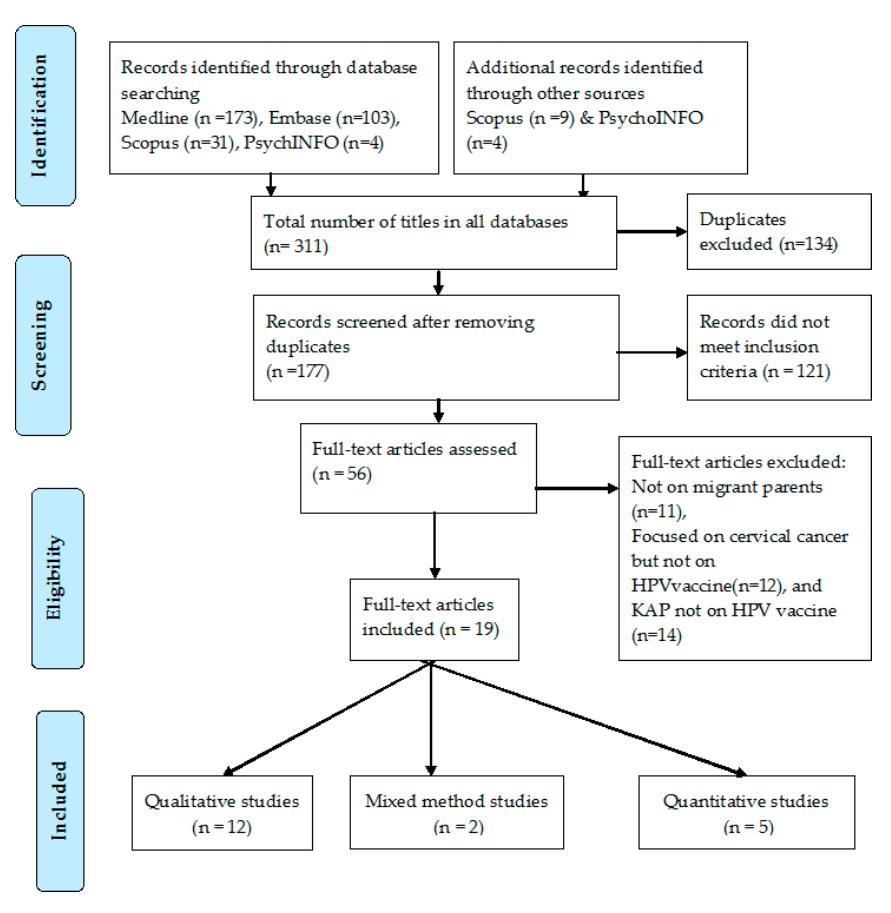
Figure 1. PRISMA flow diagram of the systematic review.